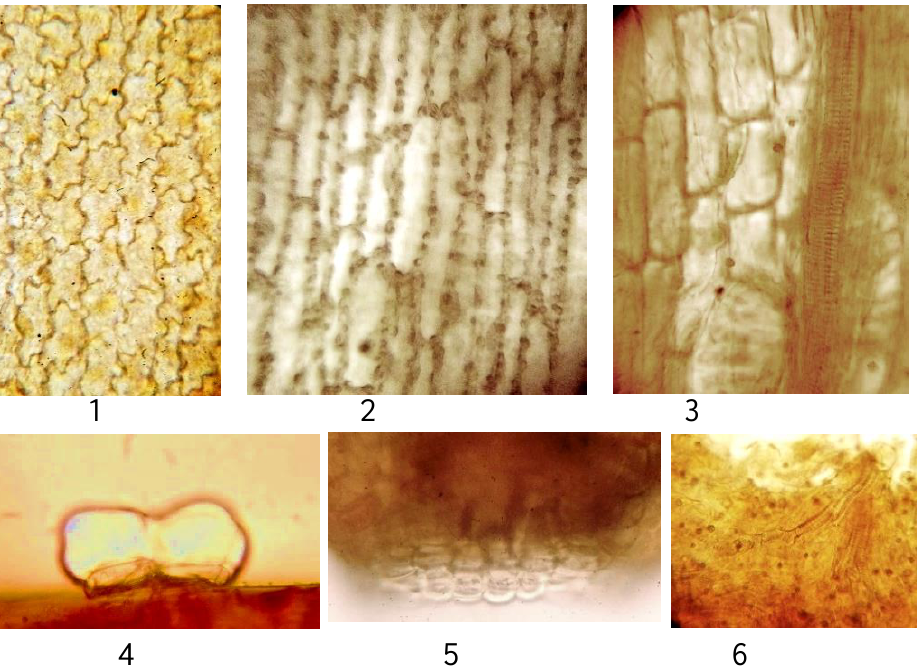
Fig. 3. Fragments of superficial preparations of false ligulate flowers: 1 – epidermis of the upper part of the tongue; 2 – epidermis of the middle part of the tongue; 3 – veins and epidermis near them; 4 – essential oil glands; 5 – basic part of the flower; 6 – cells with small